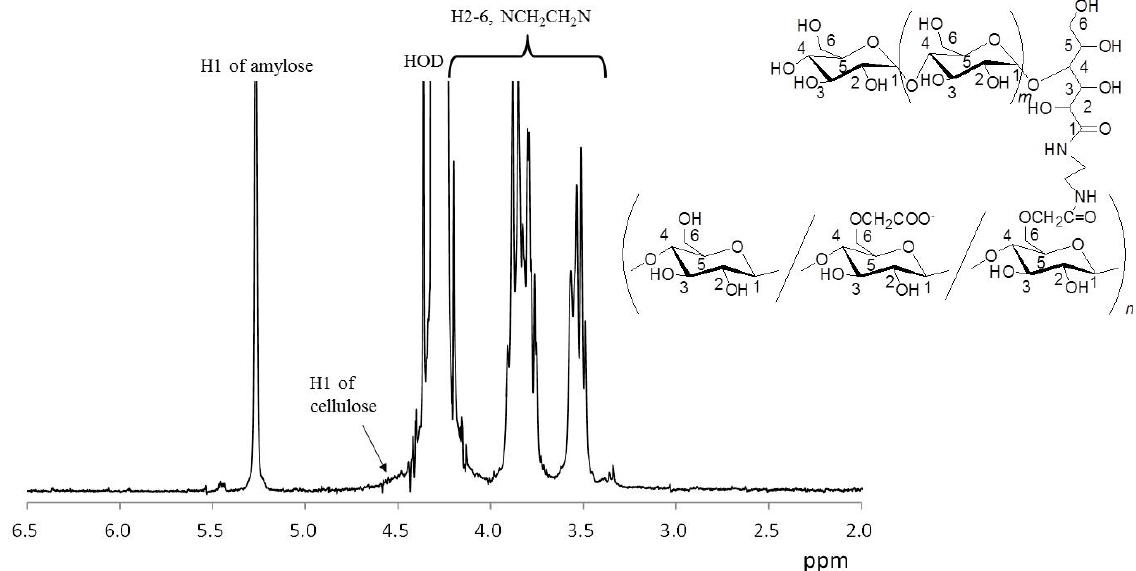
Figure 1. 1 H NMR spectrum of amylose-grafted NaCMC ( 3 ) from cotton (NaOD/D